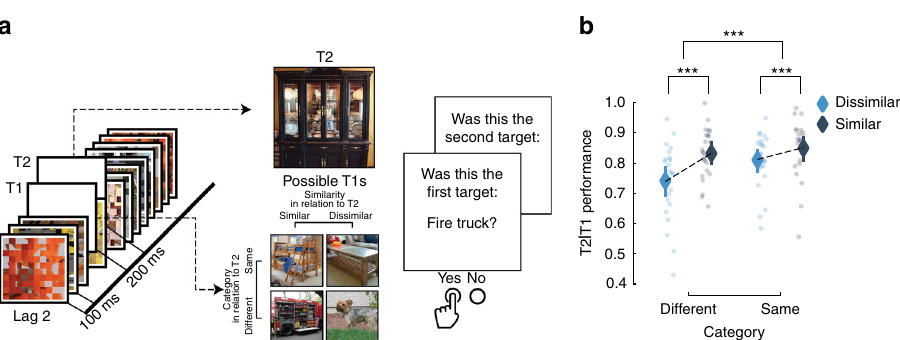
Fig. 5 Target similarity between T1 and T2 explains T2 performance. a Representational sampling was used to construct trials of experiment 2. Each of the sixteen T2s were either preceded by a T1 from the same/different category and similar/dissimilar in representational space within layer 5 of the DCNN. To ensure that participants did not use low-level statistics (such as colour) when reporting the targets, we switched the response menu to a semantic task. b Behavioural results from experiment 2. Our results show that features similarity explain a signi fi cant portion of T2 performance. Individual dots correspond to individual subjects. Error bars indicate the 95% con fi dence interval. Statistics were performed using a repeated measures ANOVA (see results). * p <0.05, ** p <0.01, ***